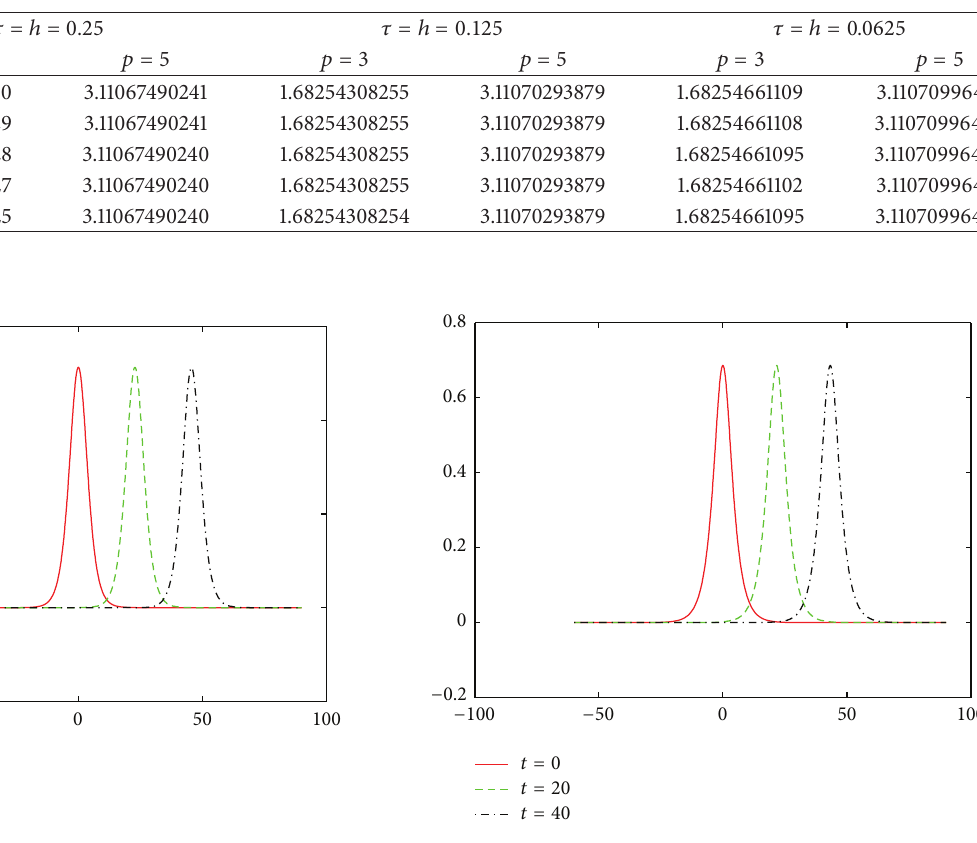
Table 4: Numerical simulations on conservation invariant 𝐸 𝑛 .